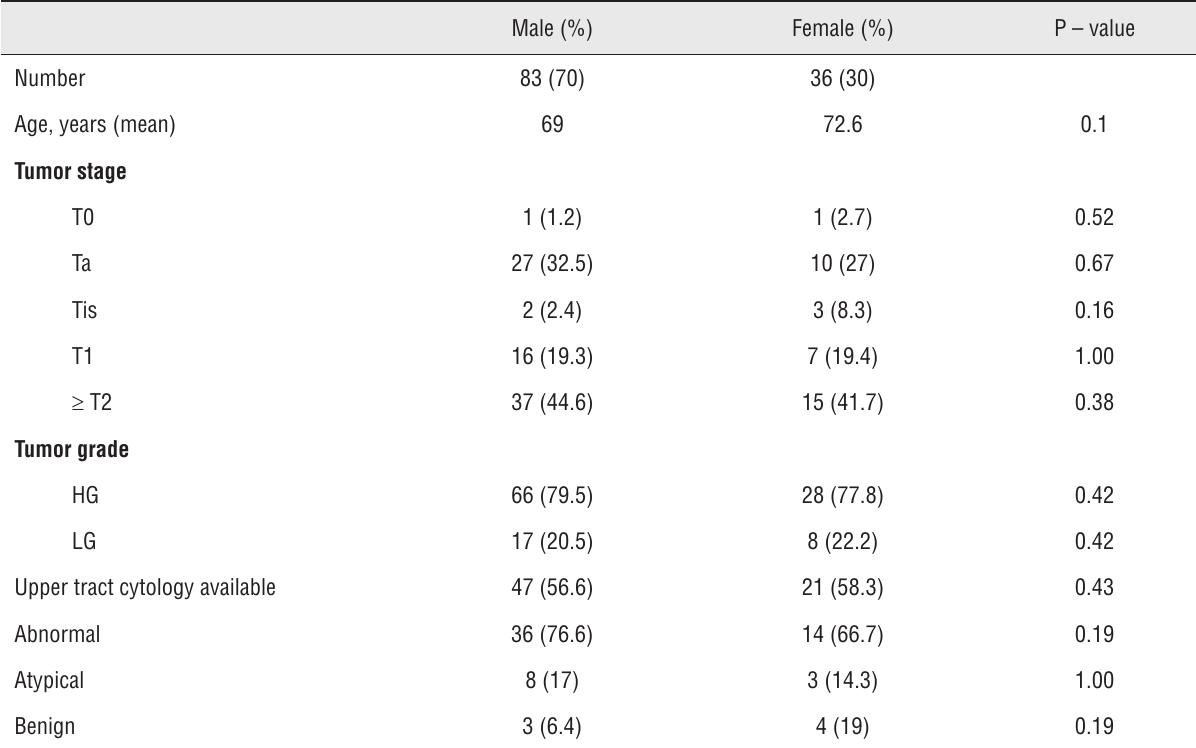
Table 1 - Characteristics of the eligible patients.